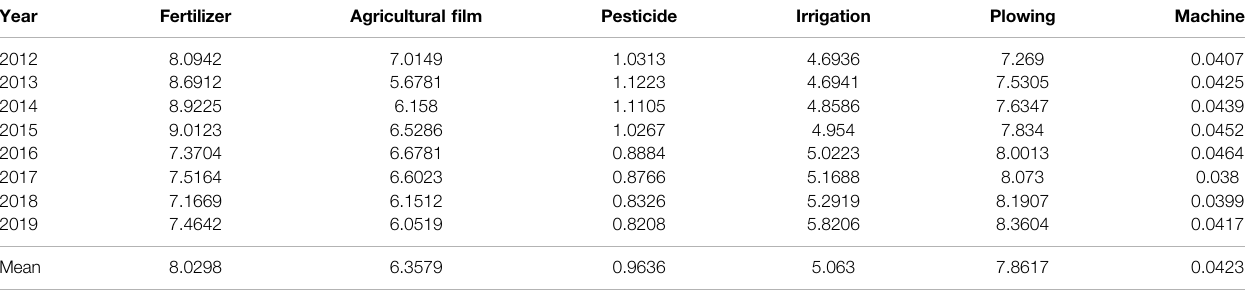
TABLE 4 | Composition of agricultural carbon emissions in Zhangye during 2012 – 2019 (unit: 10 4 t).